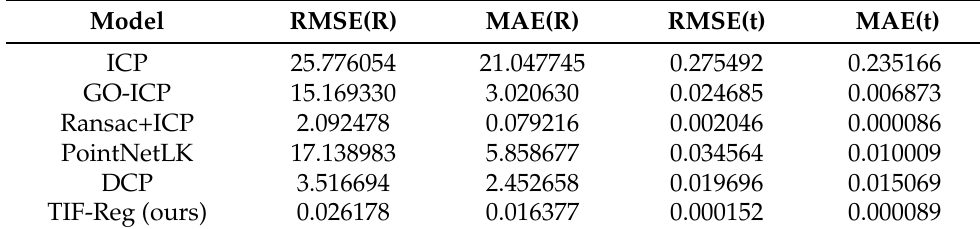
Table 2. Test on different categories in